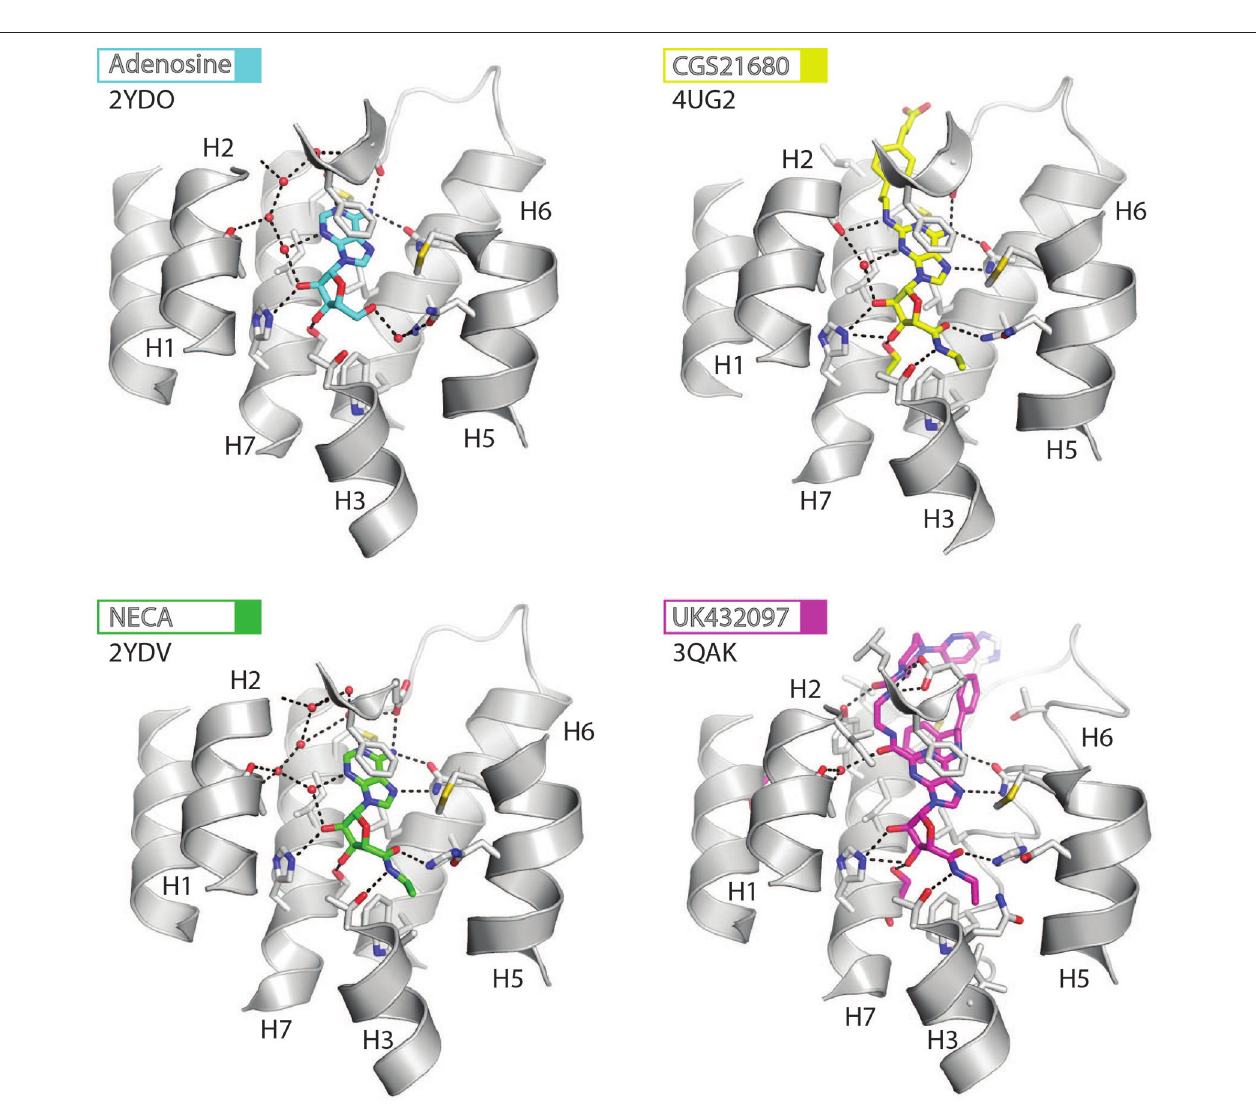
FIGURE 3 | High-resolution view of the agonist-binding site of human A 2A R. Four different agonists have been co-crystallized with A 2A R in the intermediate-active conformation. The receptor is shown as cartoons and colored gray, residues and side chains that interact with the ligand are shown as sticks and colored by element (carbon, gray; nitrogen, blue; oxygen, red; sulfur, yellow). The ligands are shown as sticks and their carbon atoms are colored to match their labels, PDB codes are shown in the figure. Polar contacts are represented as dashed lines and water molecules are shown as red